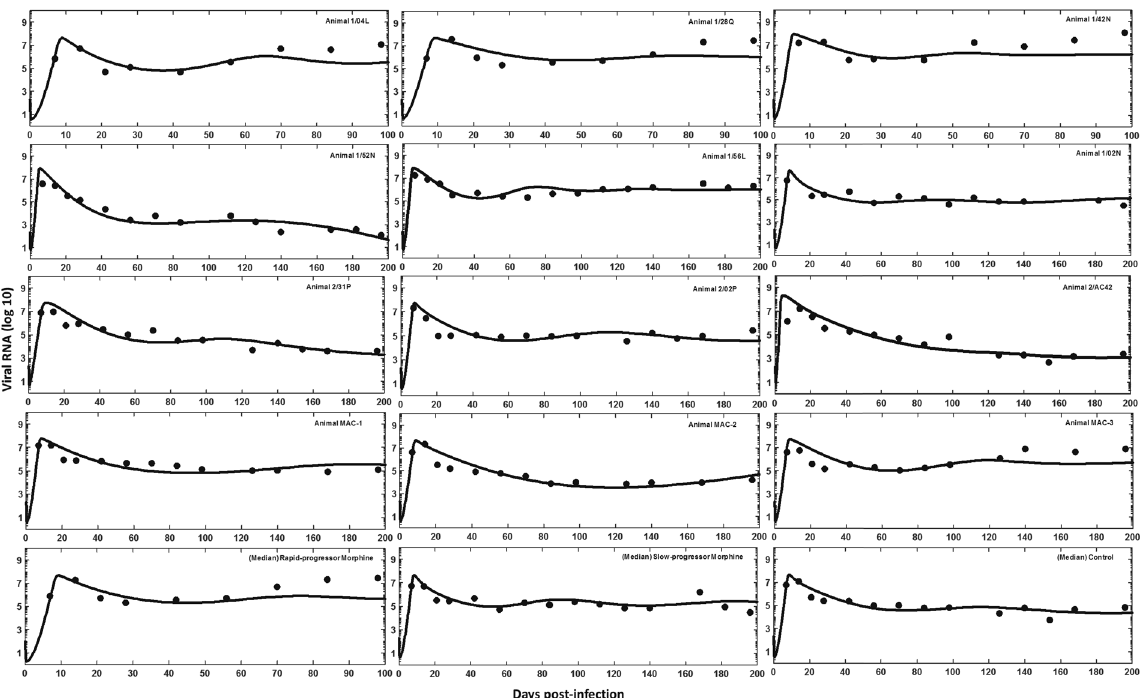
Figure 3. Best-fit viral dynamics curve using model-2 (solid line) to the experimental viral load data ( • ) for individual animals (rapid-progressor morphine group: 1/04L, 1/28Q, 1/42N; slow-progressor morphine group: 1/52N, 1/56L. 1/02N; control group: 2/31P, 2/02P, 2/AC42. MAC-1, MAC-2, MAC-3), and to the median viral load data for the rapid-progressor morphine group, the slow-progressor morphine group, and the control group.